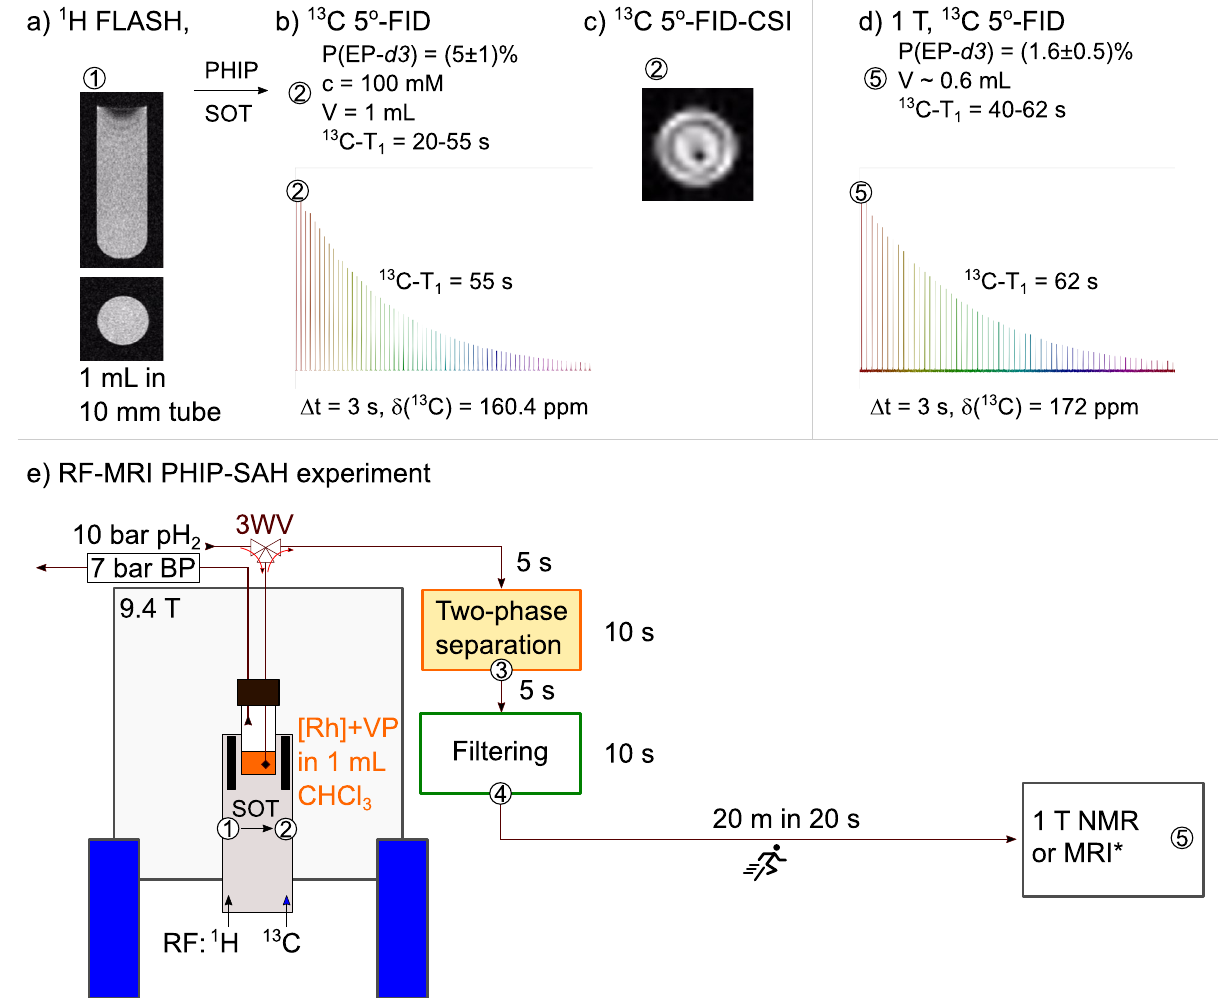
Figure 4. RF-SOT PHIP-SAH pipeline. (1, a ) Localization of the reactor (10 mm tube, 513-7PVH-7 with 1 mL solution, inner diameter 7 mm, height is 25.6 mm) in the isocenter of the wide-bore NMR with three orthogonal imaging gradients. (2) Hydrogenation followed by SOT and a 5°-FID for the quantification of polarization (Fig. 3a). Here one can also measure relaxation decay in situ ( b ) or use for 13 C-MRI in situ, here 5°-FID-CSI ( c ). Then the sample is shuttled outside for two-phase separation (3), additional chloroform filtering (4), and transportation to the MRI/NMR used for signal or image acquisition (5). Here polarization and signal decay were measured with a 1 T benchtop NMR located next door ( d ). The approximate timings of the manual sample transportation are given. The total average time from SOT to the measurement at 1 T was 50 s which is comparable with 13 C-T 1 . First, a 3-way valve (3WV) is set to enable pH 2 bubbling through the solution. Then after RF-SOT, it is rotated to extract the polarized solution under pressure from the tube for the following two- phase separation. More MR images are given in